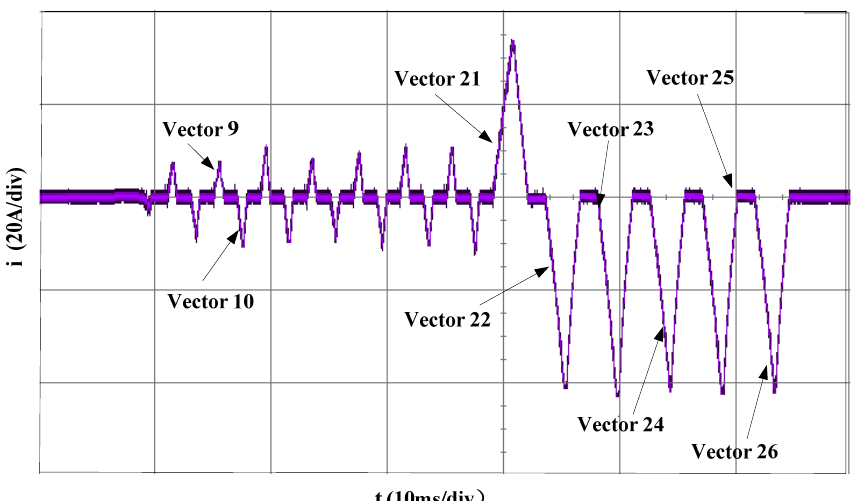
Figure 14. Current of the improved initial position estimation.